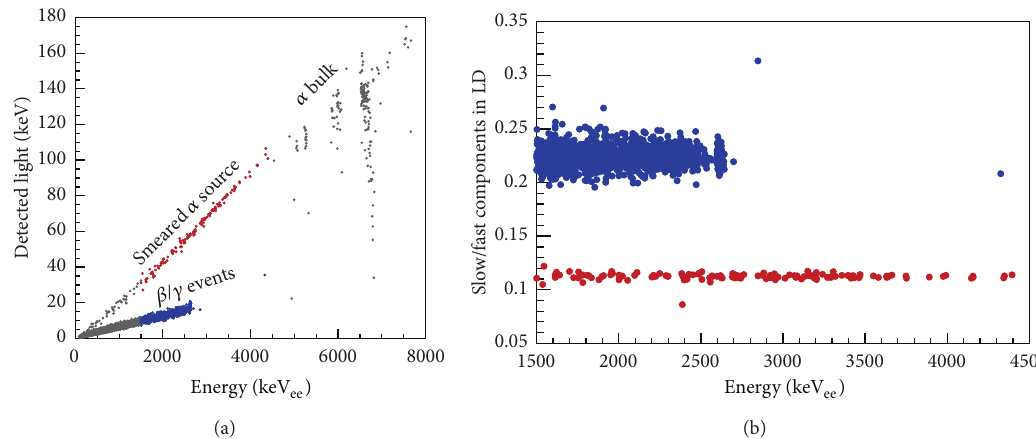
Figure 4: Particle discrimination in ZnSe. The light emitted by the ZnSe crystal (a) and the shape of the same light pulses (b) are reported as a function of the energy released in the ZnSe bolometer. A 228 Th 𝛾 -source was used to produce 𝛽/𝛾 events (blue), up to 2615 keV ( 208 Tl), while a smeared 𝛼 source was placed under the crystal to provide a continuum of 𝛼 ’s extending to lower energies (red). The (heat channel) 𝑥 -axis is (energy) calibrated using the most intense 𝛾 -peaks. The extremely different energy scale between 𝛼 and 𝛽/𝛾 events can be observed, as discussed in Section 6.1. The blue and red points of the upper plot are determined by a cut on the bottom